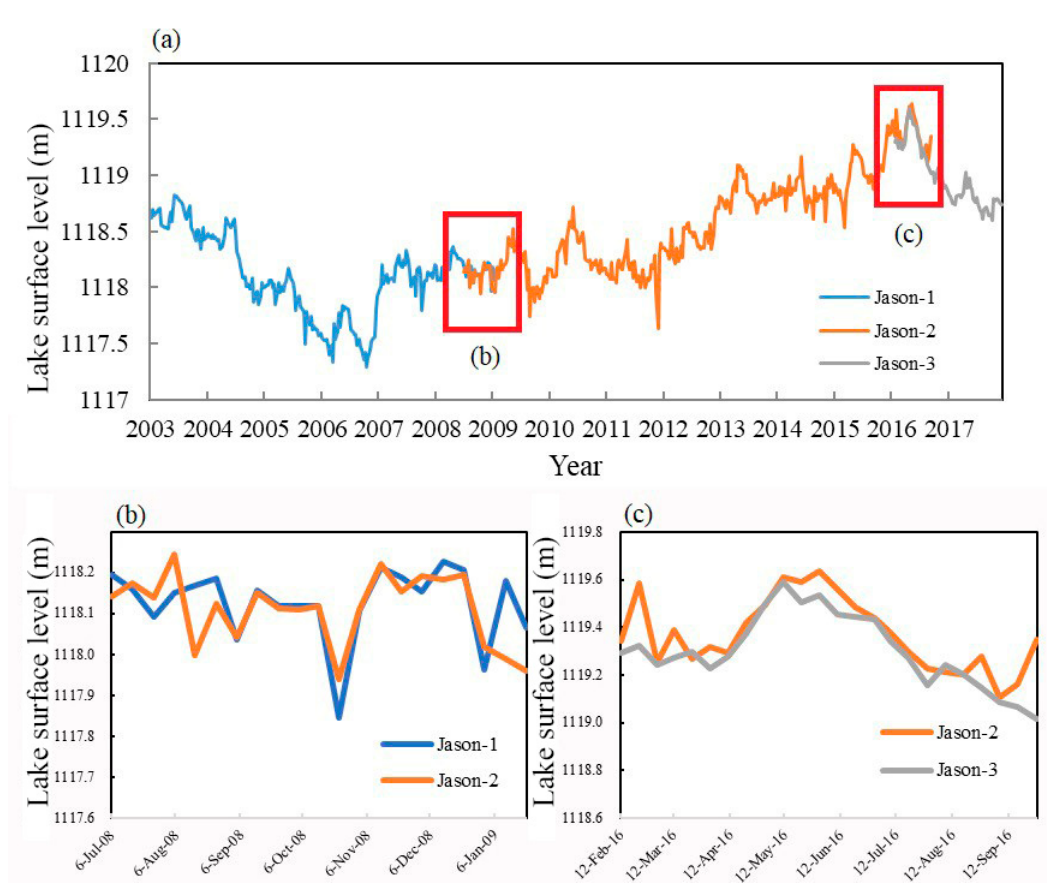
Figure 5. ( a ) Lake surface level results derived from Jason-1, -2, and -3 before eliminating the systematic bias; ( b ) Overlapping period between Jason-1 and -2; ( c ) Overlapping period between Jason-2 and -3.